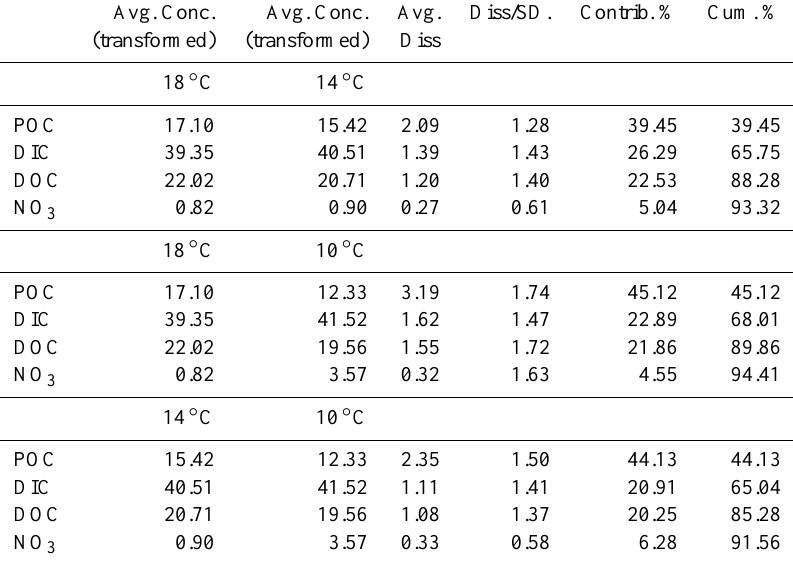
Table 3. Results of a SIMPER analysis for the contributions of different biogeochemical variables to the differences between temperature treatments. Shown are biogeochemical variables that contribute to 90% of dissimilarity, with average concentration (square root trans- formed), average dissimilarity, ratio of average dissimilarity and respective standard deviation, as well as percentages of contribution and cumulative contribution. Average dissimiliarity between temperature treatments: 18 ◦ C and 14 ◦ C = 5.30; 18 ◦ C and 10 ◦ C = 7.08; 14 ◦ C and 10 ◦ C = 5.32. Avg. Conc. Avg. Conc. Avg. Diss/SD. Contrib. % Cum. % (transformed) (transformed) Diss 18 ◦ C 14 ◦ C POC